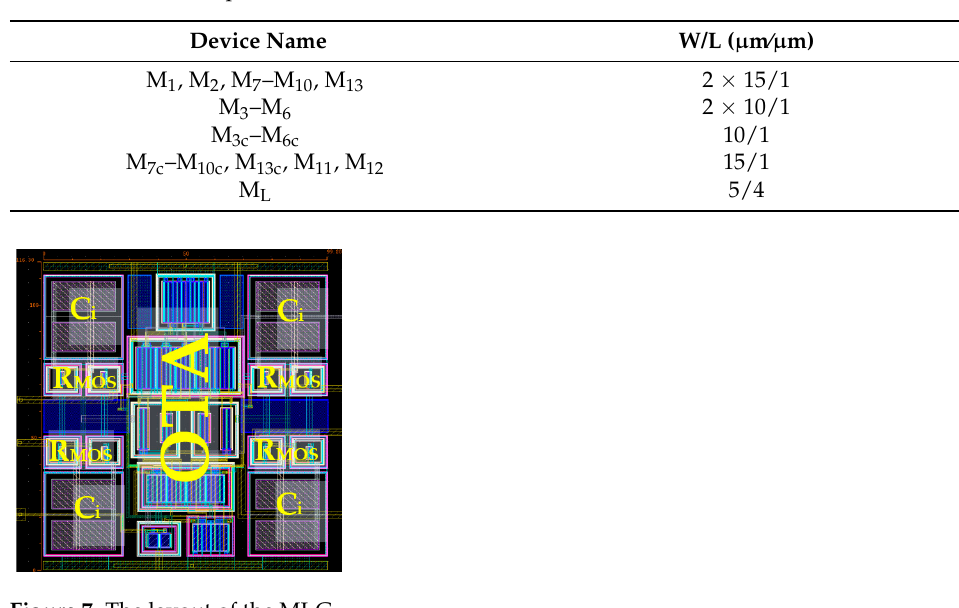
Figure 8. DC transfer characteristic of the MI-G m .